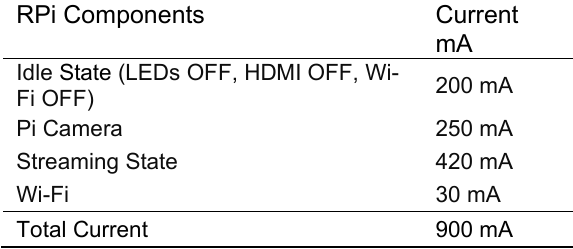
Table 1. Sensor node’s current consumption